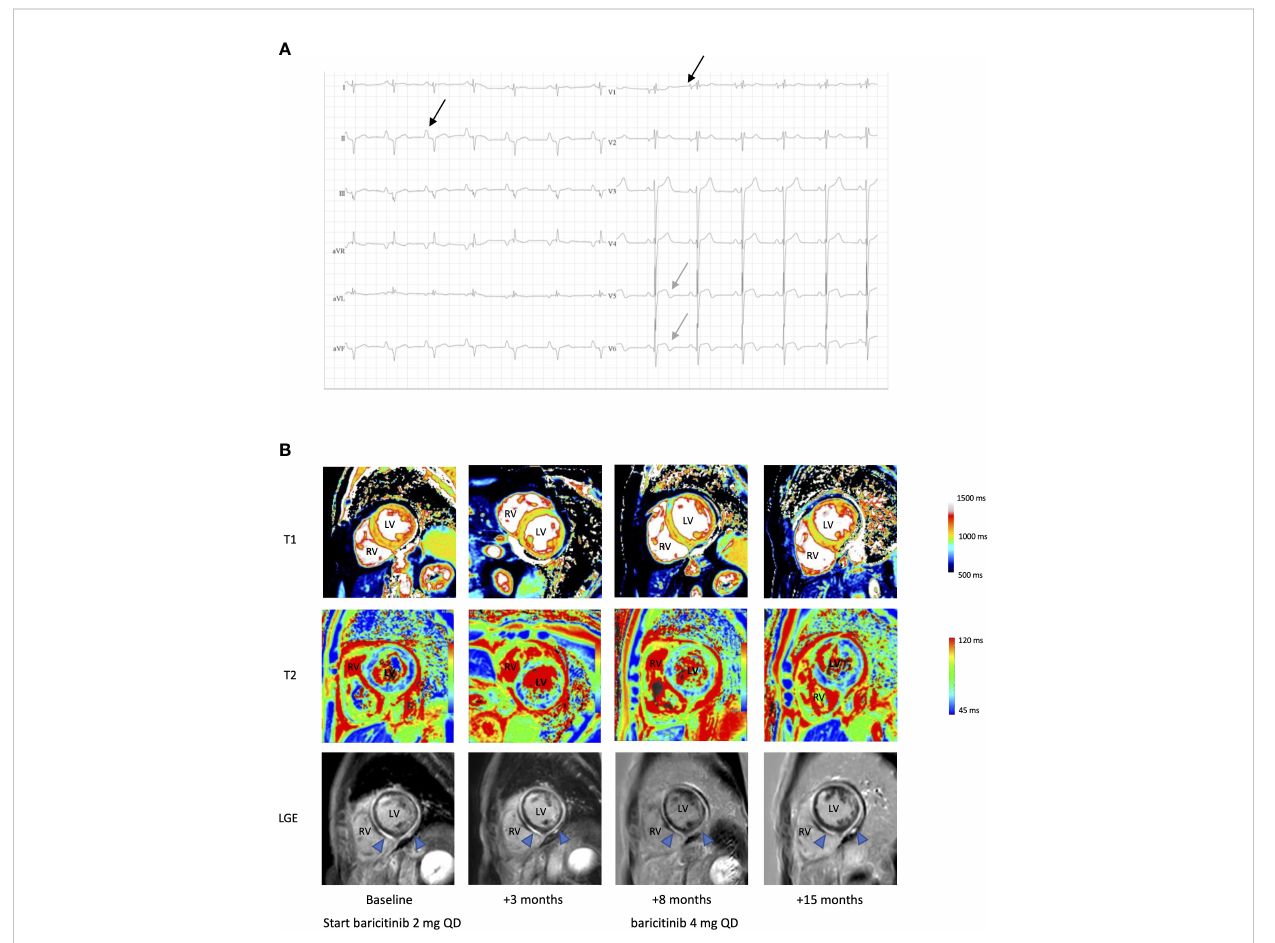
FIGURE 2 Electrocardiographic and radiological fi ndings in a patient with STAT1 GOF and myocarditis. (A) ECG, showing bi-atrial enlargement (black arrow, biphasic P wave in V1 and enlarged P wave in II), extreme rightward QRS axis deviation and biphasic T waves in V5-6 (grey arrow). (B) Cardiac native T1 map, T2 map and late gadolinium enhancement (LGE) MR images pre- and post-baricitinib. LV, left ventricle; RV, right ventricle. Blue arrow in LGE showing diffuse enhanced subepicardial and myocardial enhancement compatible with active myocarditis, partial regression after 8 months of treatment, with further reduction at 15 months after a dose